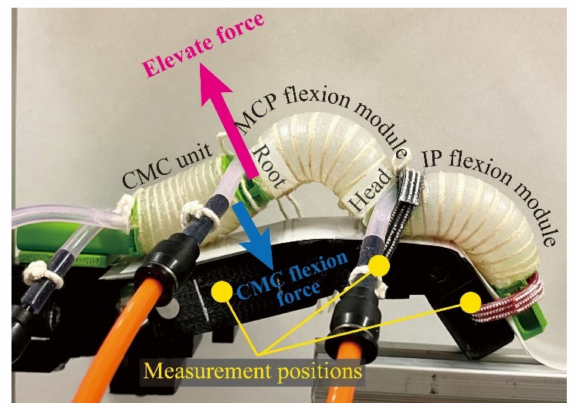
Figure 9. The deformation of a modular thumb actuator during excessive air